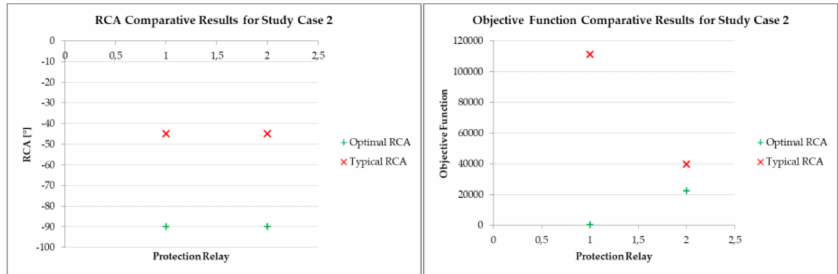
Figure 18. Comparative results for the evaluation of polarization on the directional ground overcurrent element (ANSI 67N) in the protection relays of Study Case 3—zero sequence